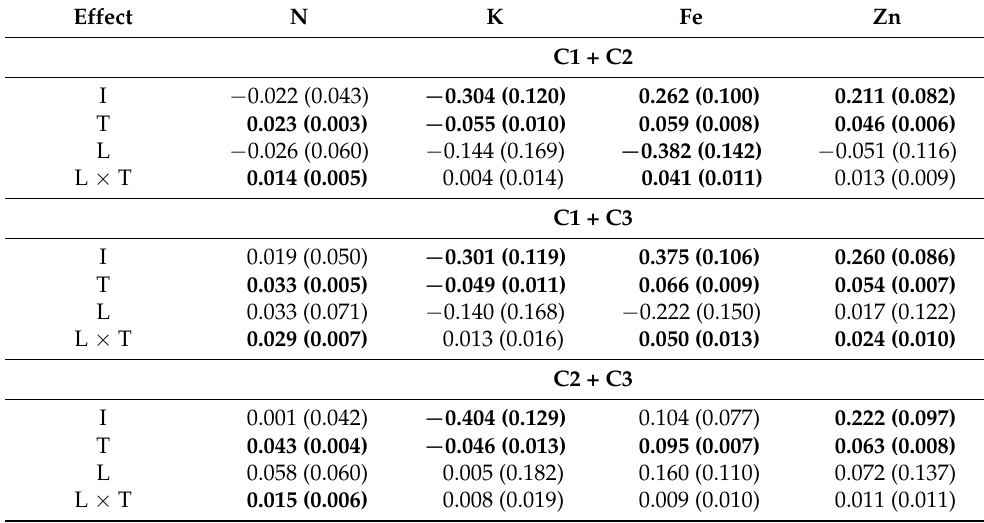
Table 2. Coefficients obtained from the adjustment of the generalized linear mixed models for the remaining nutrient concentration of E. grandis forest litter according to the comparison set.